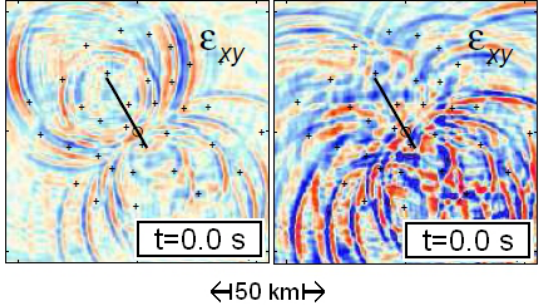
Fig. 10. Snapshots of the time-reversed strain component (cid:15) xy at 12 . 5km depth and t = 0 for the weighted adjoint sources. Left: weight proportional to the squared epicentral distance. Right: weight proportional to the inverse energy 2 / R v ( x r ) 2 dt